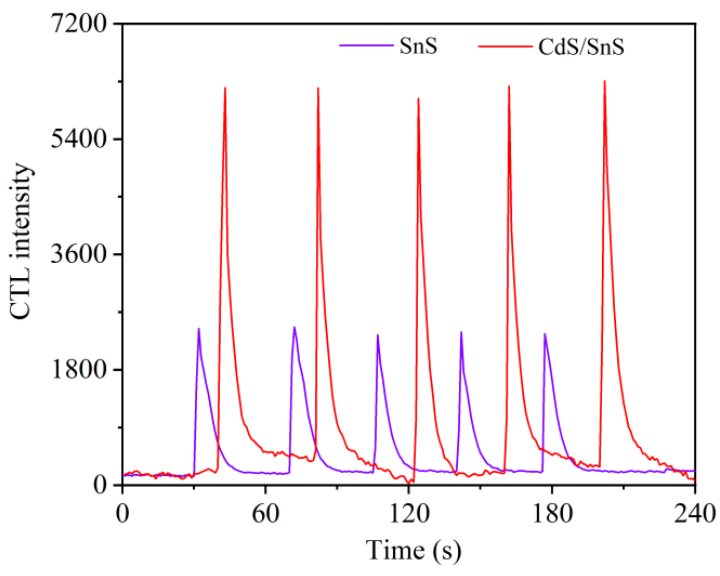
Figure 6. Comparison of CTL strength of pure SnS and CdS/SnS (flow rate: 280 mL/min; temperature: 162 ◦ C; concentration: 33.75 ppm).